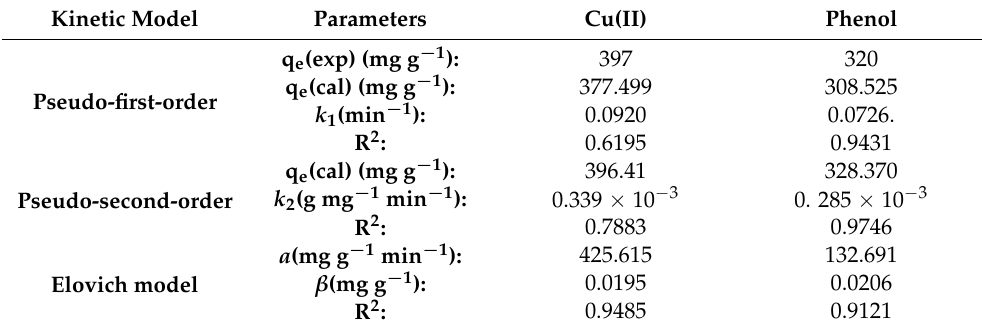
Table 1. Adsorption kinetics parameters for Cu(II) and Phenol onto PANI@WTP nanocomposite.